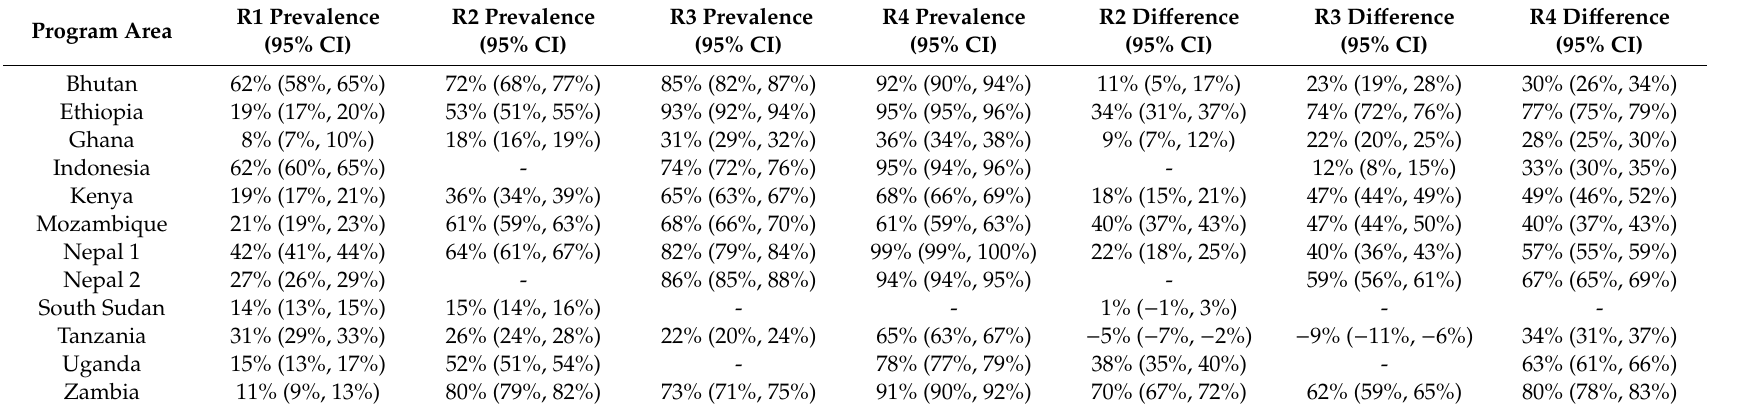
Table A1. Coverage and change in basic sanitation by program